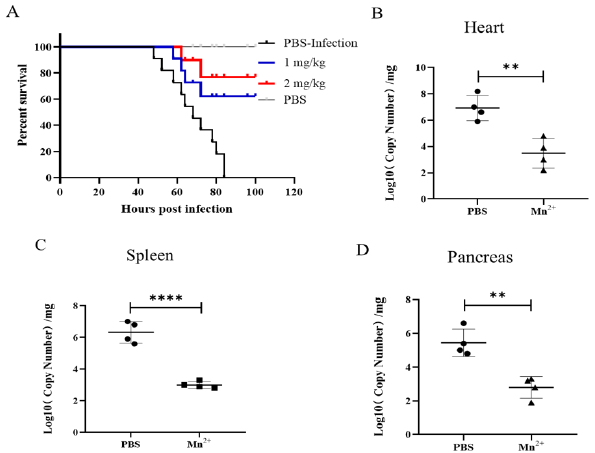
Figure 4. Survival rates of mice injected with Mn 2+ after being challenged with FMDV. C57BL/6N mice were inoculated with 1 mg/kg or 2 mg/kg Mn 2+ by intravenously (I.V.) injection at 12 h before FMDV infection. PBS was inoculated by I.V. injection at 12 h before FMDV infection, as the negative control. Mice were challenged with 2 × 10 5 TCID 50 of FMDV by I.P. injection. The mice were monitored for 5 days. ( A ) Mn 2+ treated mice were partially resistant to FMDV-induced death ( n = 10 per group). FMDV RNA was reduced in the heart ( B ), spleen ( C ), and pancreas ( D ) of FMDV-infected mice for 48 h following Mn 2+ treatment ( n = 4 per group). A t -test was performed to identify statistically significant differences. **, p < 0.01; ****, p < 0.0001.